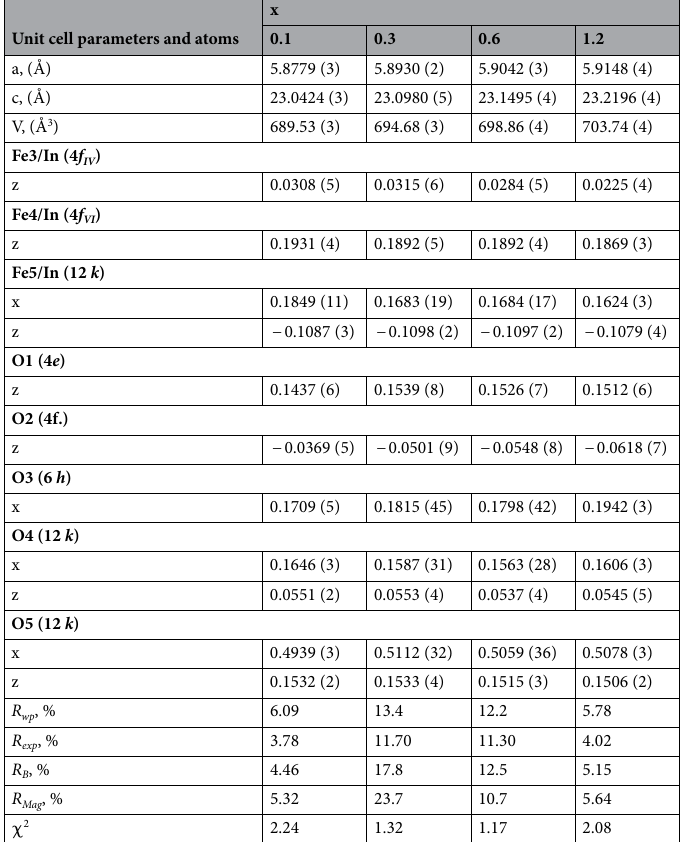
Table 1. Refined unit cell parameters, atomic positions and reliability factors for the SrFe 12 −x In x O 19 (x = 0.1– 1.2) samples obtained by the Rietveld method in framework of the P 6 3 /mmc (No. 194) space group at room temperature. Fixed atomic positions for this case are: Sr (2d) (2/3, 1/3, 1/4), Fe1 (2a) (0, 0, 0); Fe2 (2b) (0, 0, 1/4); (Fe/In)3 (4